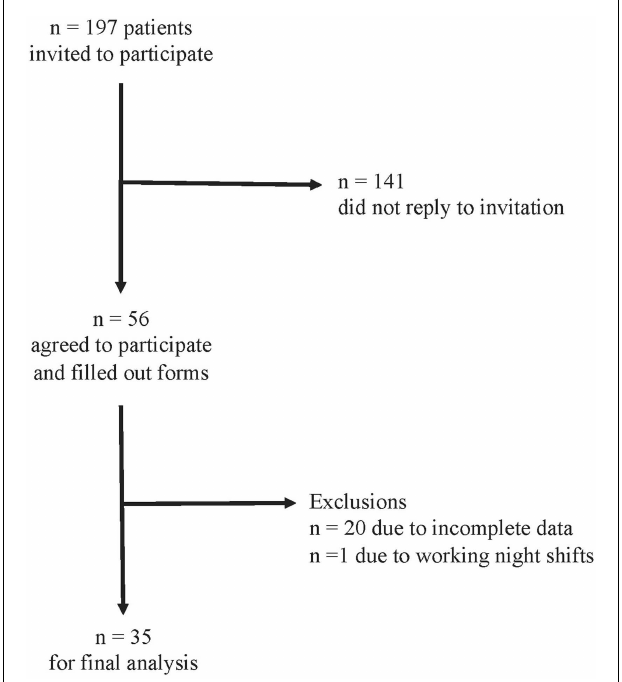
FIGURE 1 | Study flow chart of patient enrollment and data analysis .